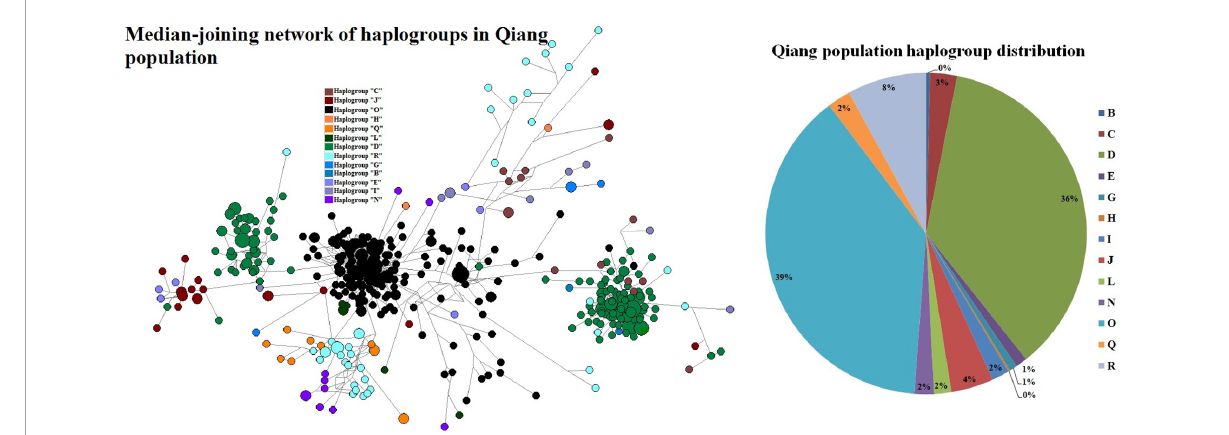
FIGURE2 Median-joining network of the predicted haplogroups in the Qiang people and haplogroup frequency distribution.